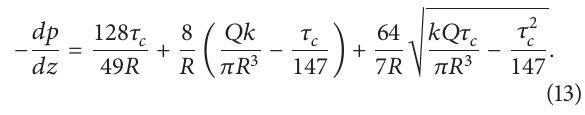
Figure 2: Stenosis geometries for different values of stenosis height 𝑎 .